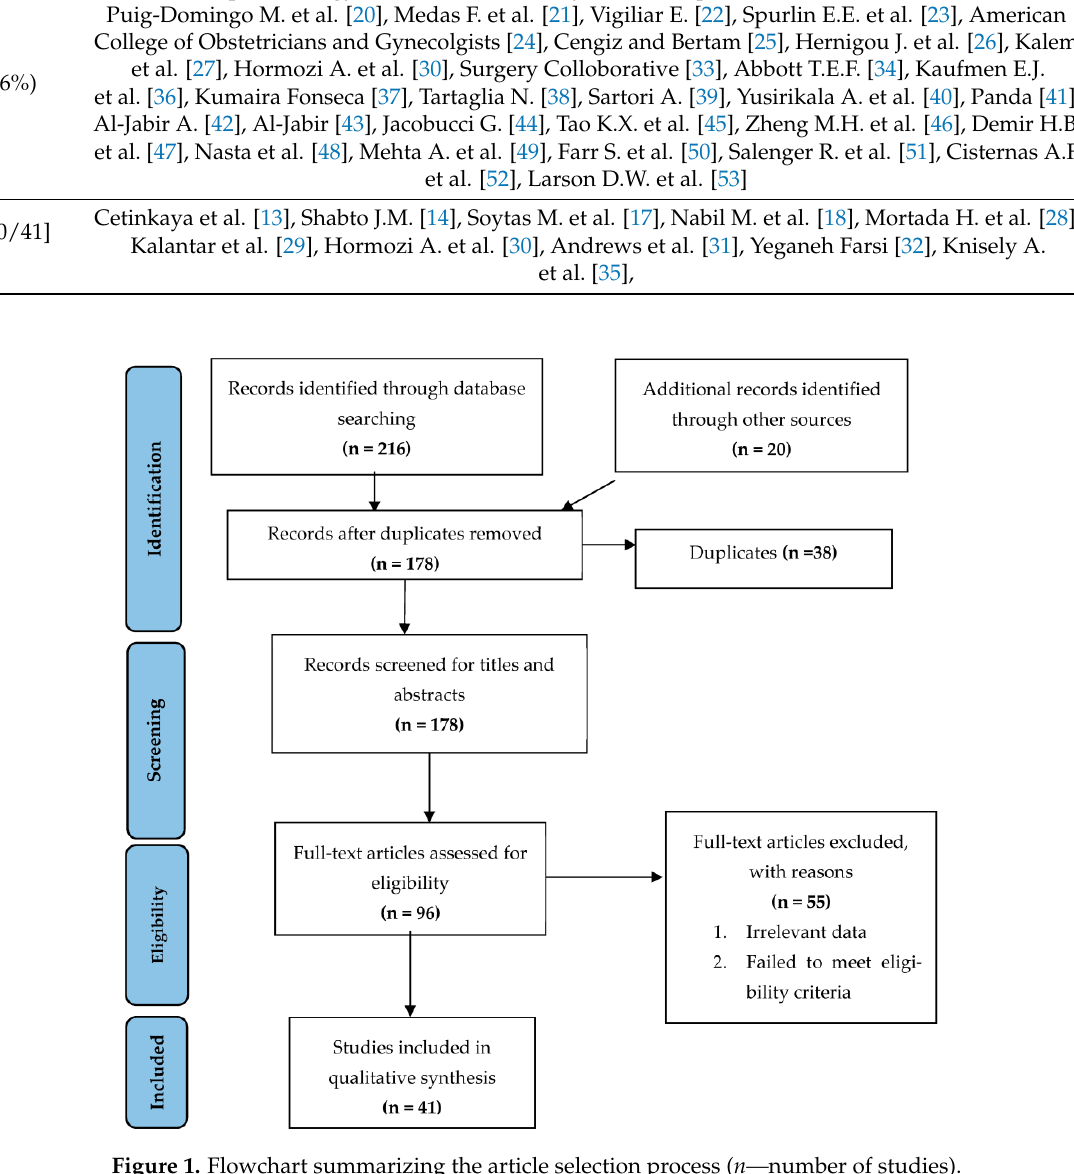
Figure 1. Flowchart summarizing the article selection process ( n — number of studies). Table 2. Intervals of the studies conducted.